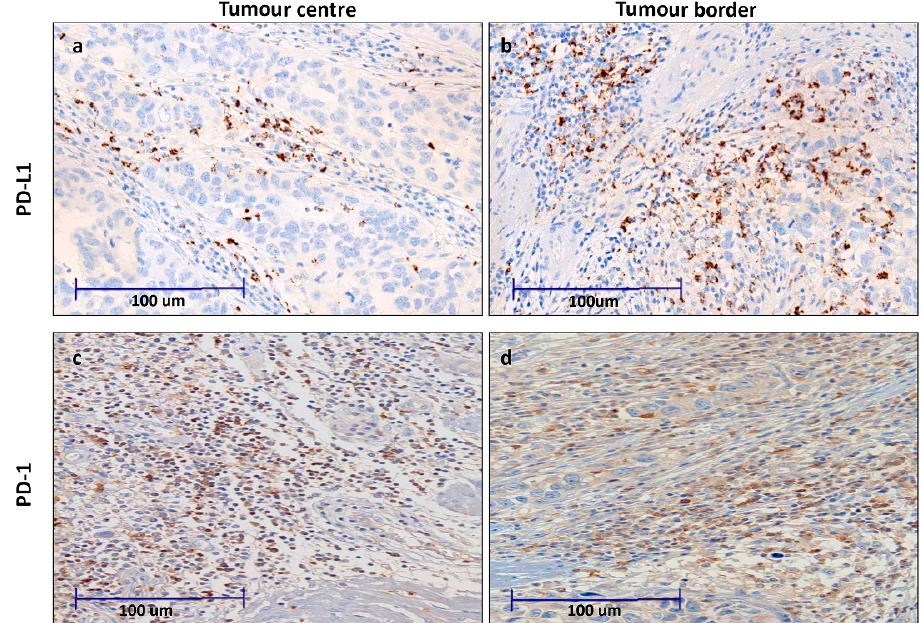
Figure 1. Immunohistochemical expression of PD-1 (sPD-1) and PD-L1 (sPD-L1) staining in inflammatory cells in clear cell renal cell carcinoma (CCRCC) samples, both in the tumor center ( a , c ) and infiltrating front ( b , d ).